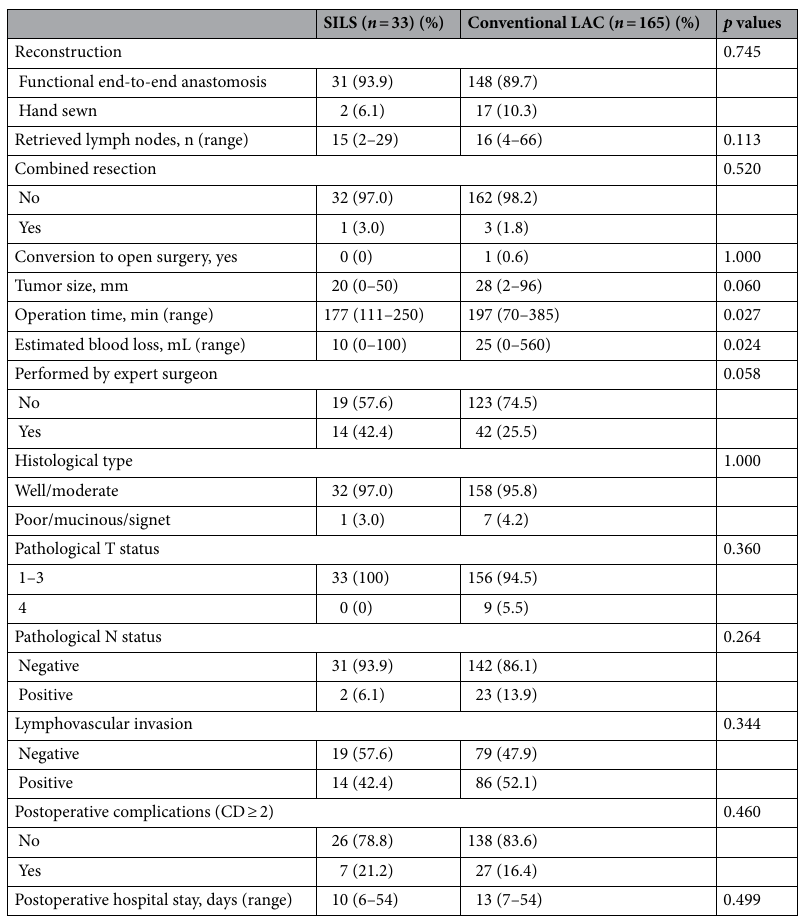
Table 3. Comparison of surgical and pathological characteristics between SILS and conventional LAC. Differences in categorical variables were compared using Fisher’s exact test or the chi-squared test, as appropriate. Differences in continuous variables were analyzed with the Mann–Whitney U -test. CD Clavien- Dindo grade, SILS single-incision laparoscopic surgery, LAC laparoscopic